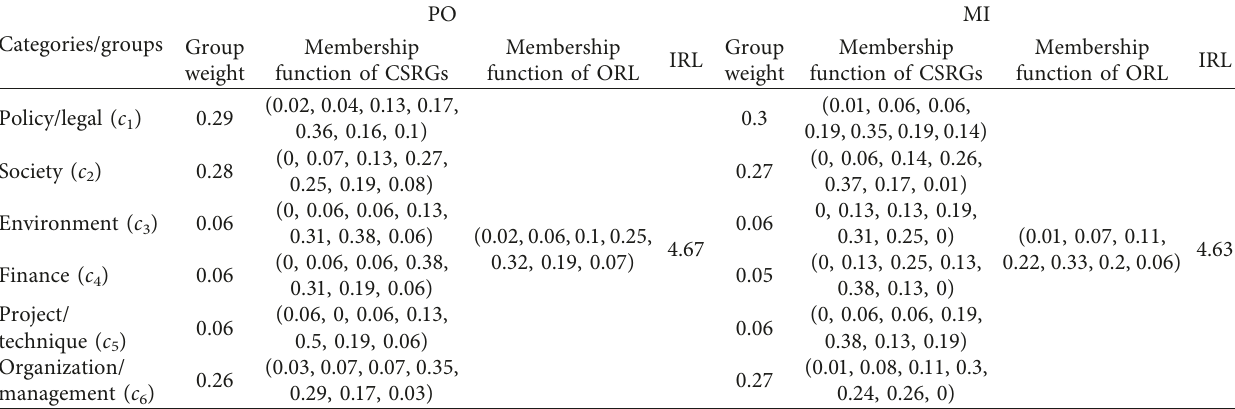
Table 7: Membership functions of the overall risk level.